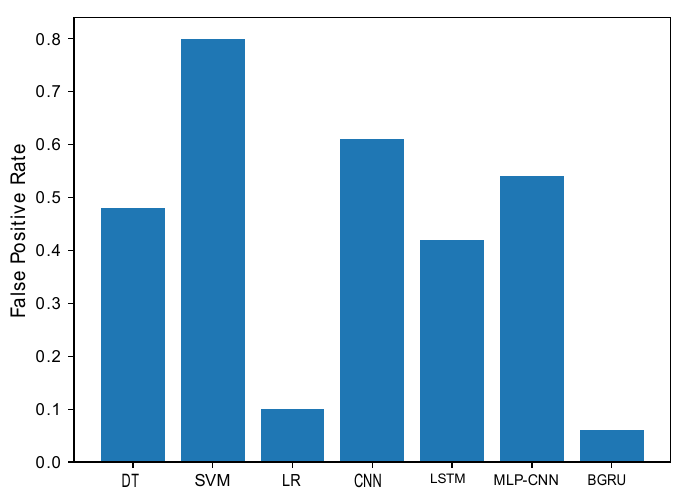
Figure 13. Comparison of BGRU with ther techniques in terms of False Positive Rate (FPR). RMSE calculates the distance between acutal sample and predictied sample. The RMSE of BGRU is 0.044, which is lowest as compared to other existing deep learning models as shown in Figure 14; however, the RMSE of RF is highest at 0.400.